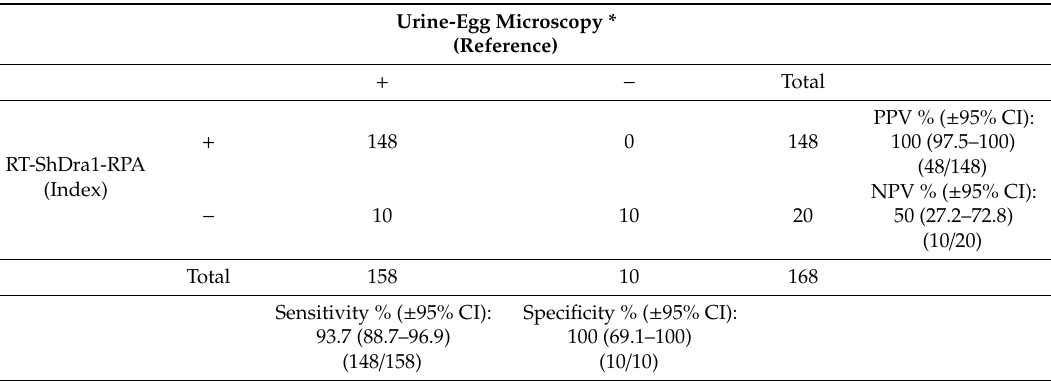
Table 1. Diagnostic performance of the RT-ShDra1-RPA assay (index), compared to a urine-egg microscopy reference test*. Sensitivity, specificity, positive predictive value (PPV) and negative predictive value (NPV) ± confidence intervals ( ± 95% CI) are provided. Associated calculations are indicated within